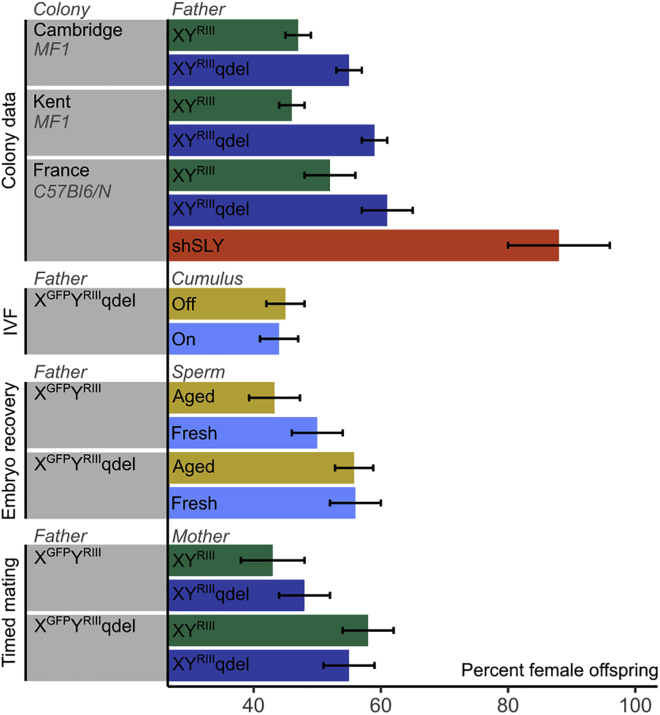
Sex Ratios Observed in Colony Mating and in Embryos Generated by IVF versus Natural Mating and Scored at Differing Time PointsSee also Table S1 for raw counts. XYRIIIqdel animals and XGFPYRIIIqdel embryos show a marked sex ratio skew in favor of females when mated naturally, but this is abolished in IVF experiments. XYRIIIqdel animals and XGFPYRIII and IVF-derived XGFPYRIIIqdel embryos show a slight skew in favor of males. Error bars show SE of proportion.